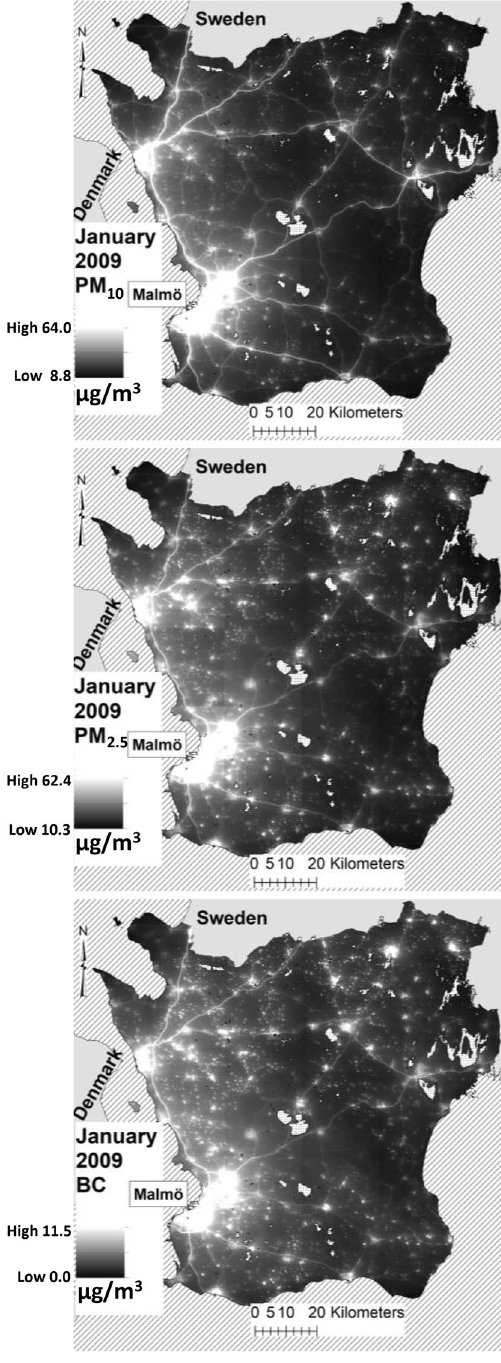
, PM and BC in Scania with during 10 2.5